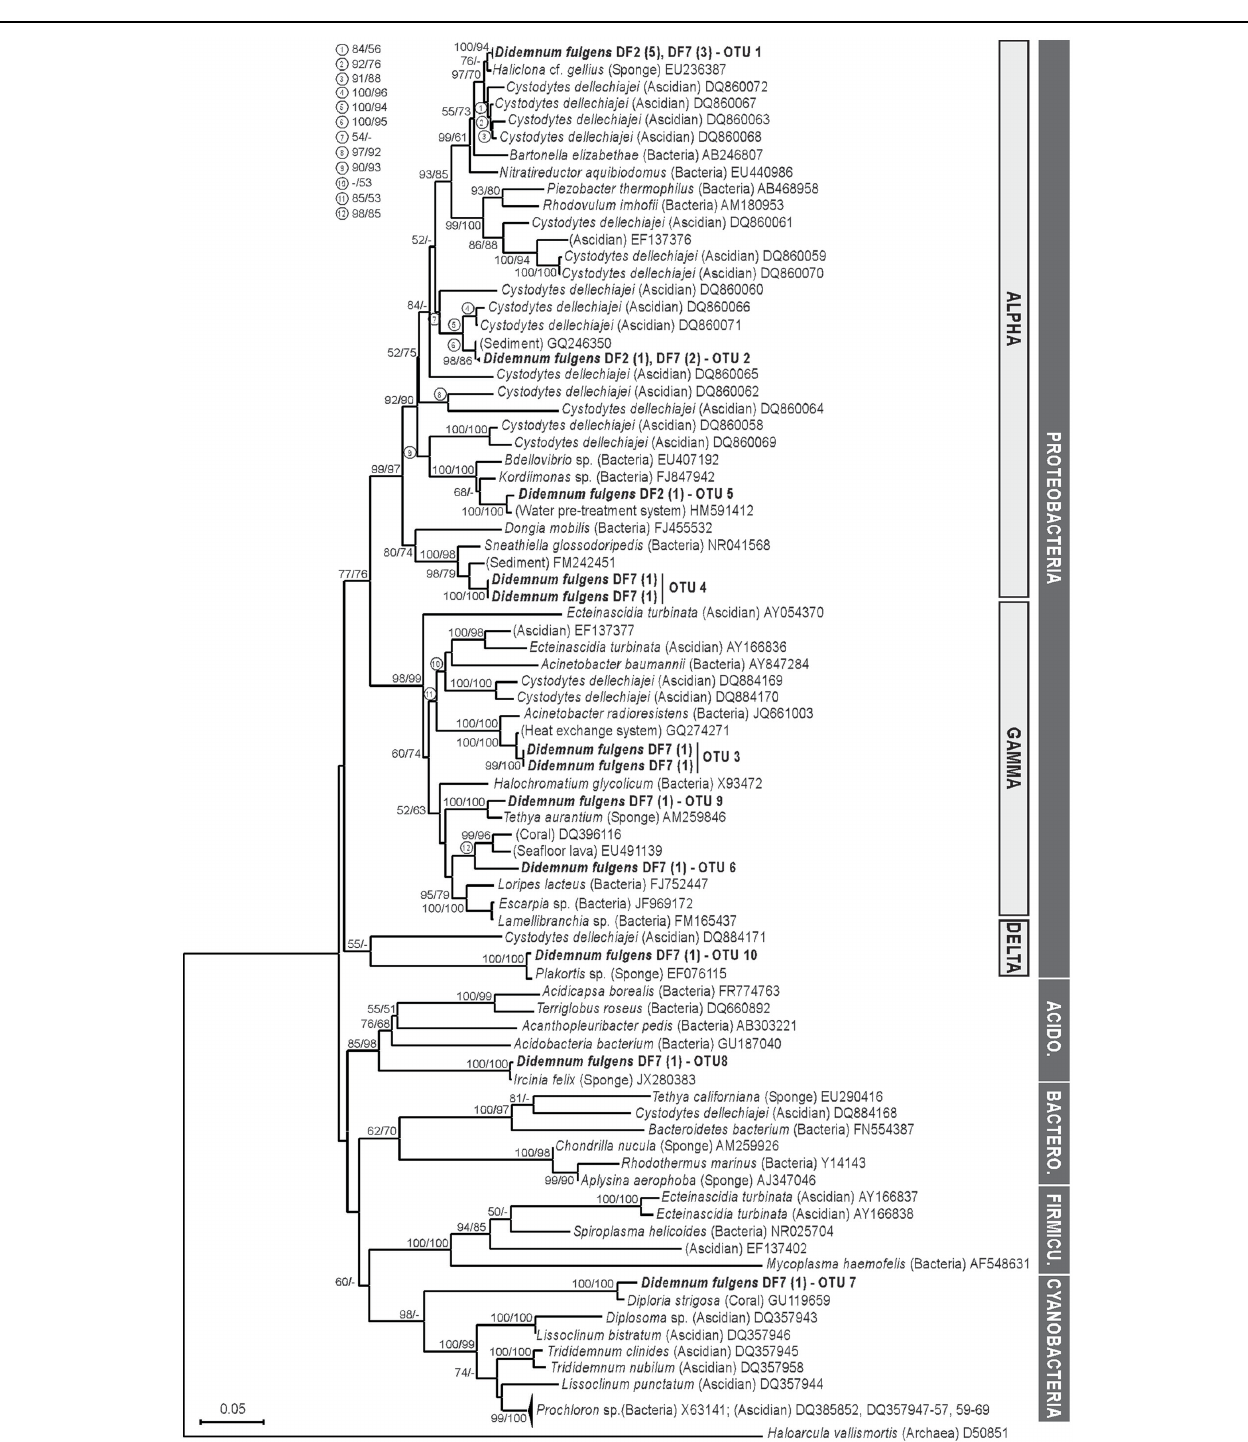
FIGURE 2 | Phylogeny of partial bacterial 16S rRNA gene sequences in D. fulgens. Sequences obtained in this study are highlighted (bold lettering). Labels on terminal nodes of reference sequences indicate host or bacterial species, sources (in parenthesis) and GenBank accession numbers. Labels on terminal nodes